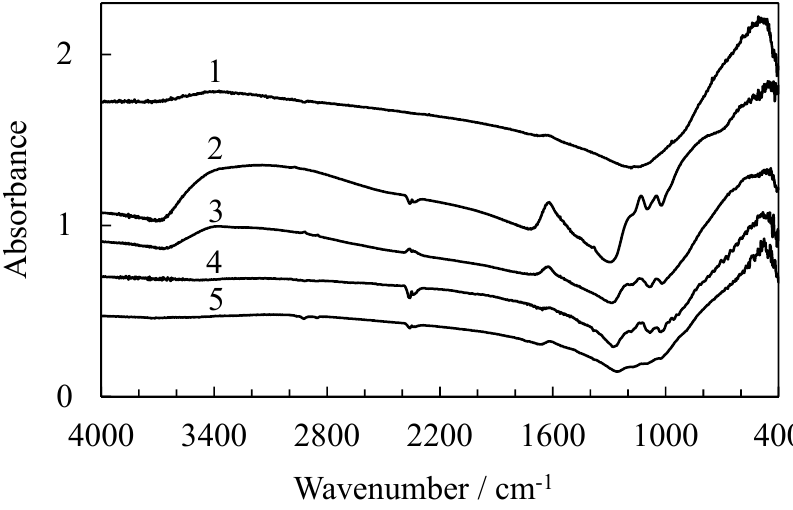
Figure 4. FTIR spectra of (1) Sample T; (2) Sample S0; (3) Sample S300; (4) Sample S400 and (5) Sample